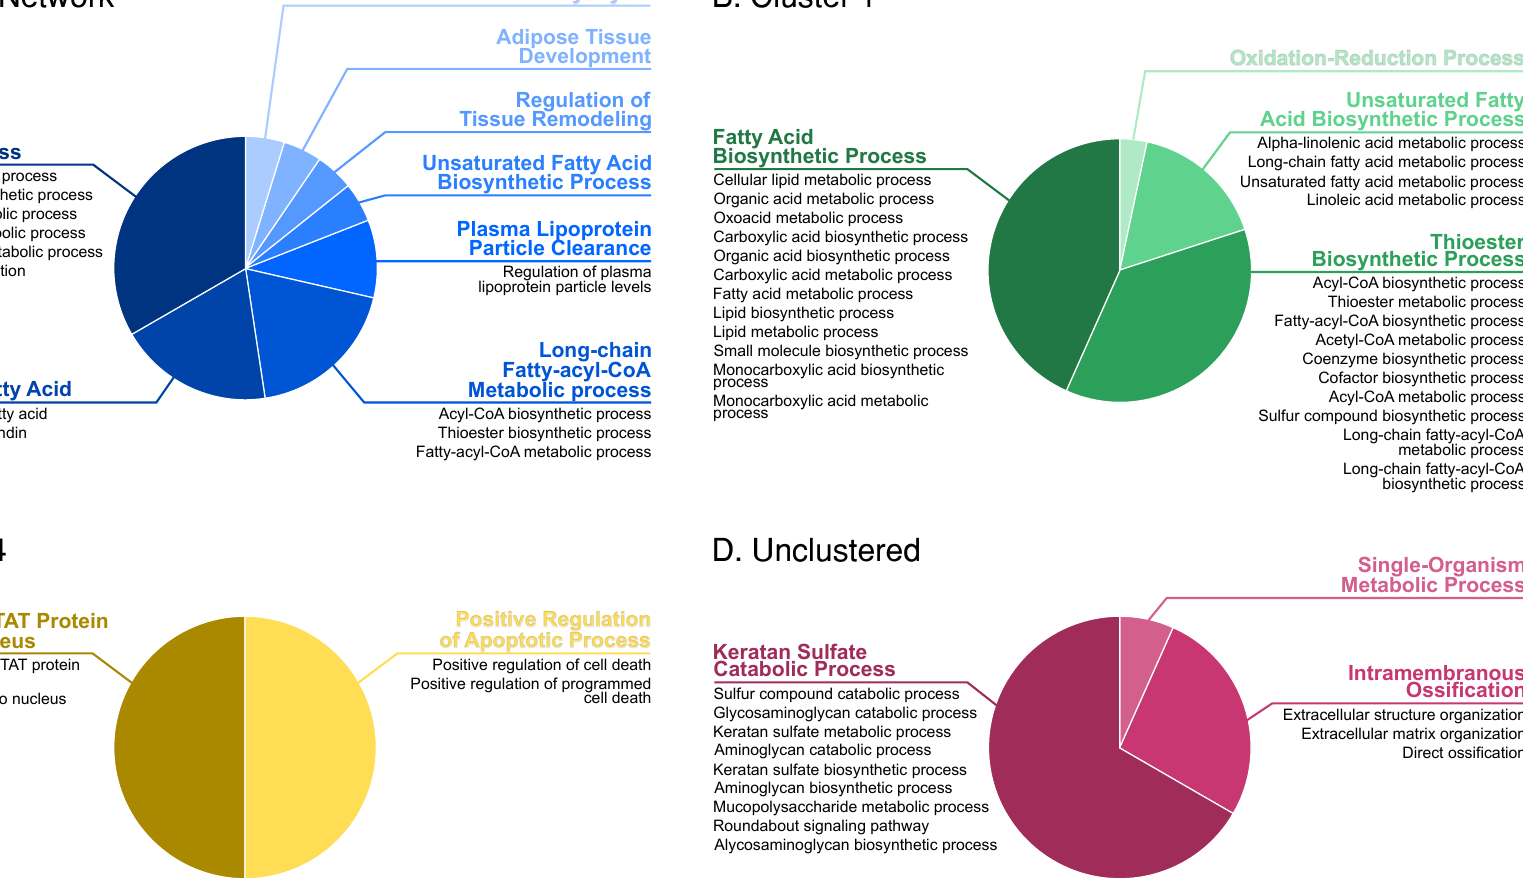
Figure 5. Gene ontology term pie charts constructed using the ClueGO results. Each pie chart contains major GO terms as slices, with sub-terms listed underneath each. ( A ) GO term pie chart for the overlap network; ( B ) GO term pie chart for Cluster 1; ( C ) GO term pie chart for Cluster 4; ( D ) GO term pie chart for un-clustered gene